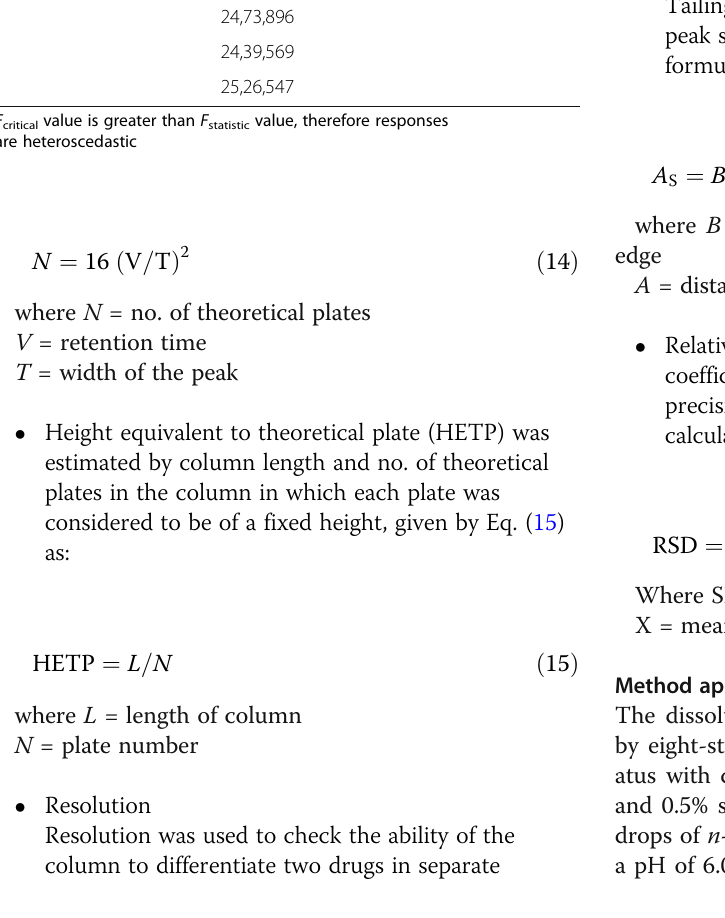
Table 4 Regression equation, correlation coefficient, and sum of the relative errors for each weighted and unweighted factor Model